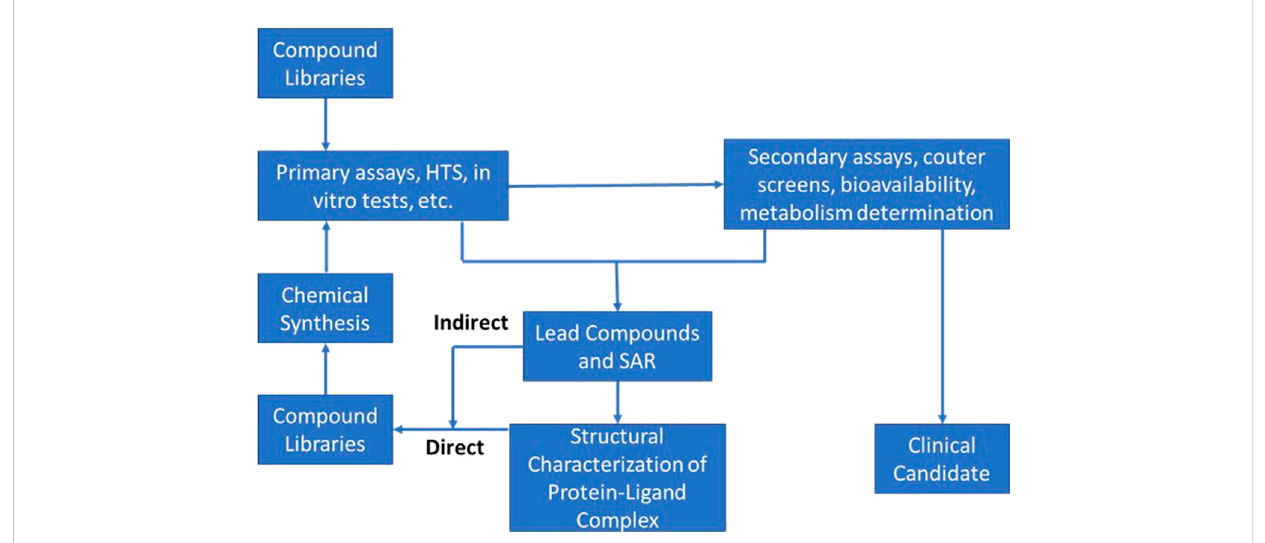
FIGURE 1 Schematic of typical Discovery phase activities used in the process of target identi fi cation and early candidate selection; often referred to and described as the “ DMTA cycle ”